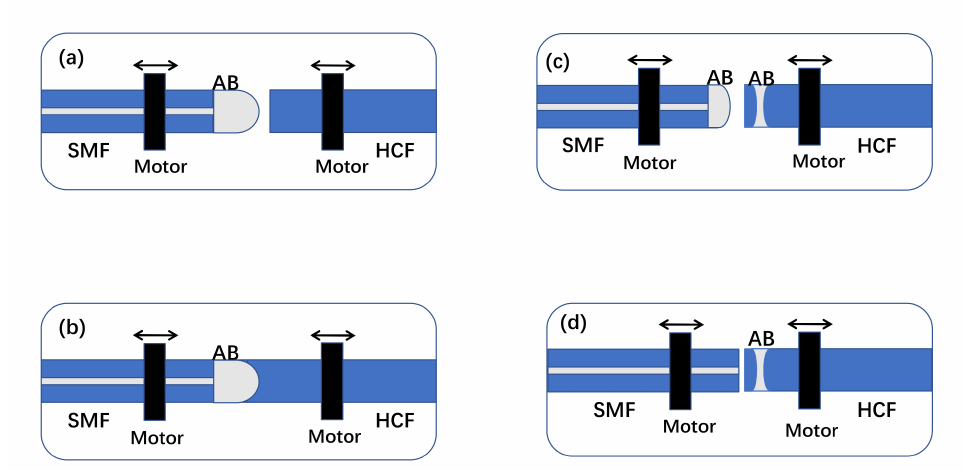
Figure 3. Flow chart of sensors structure preparation: ( a ) the SMF with the AB epoxy adhesive film and cut HCF are placed at both sides of the optical fiber fusion splicer; ( b ) the SMF and HCF are accurately contacted by optical fiber fusion splicer; ( c ) the AB epoxy film is transferred to the HCF due to capillary action; ( d ) the SMF with the ASE is connected the HCF with the AB epoxy film by fusion splicer.